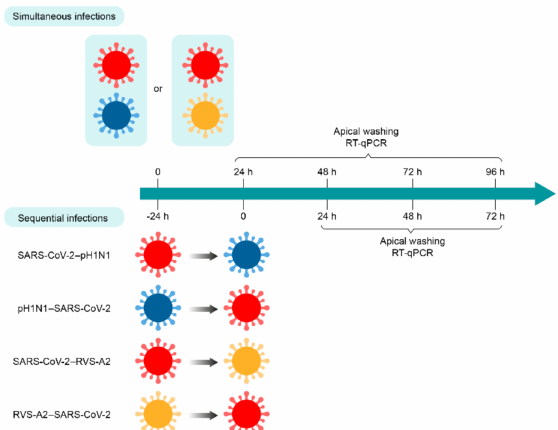
Figure 1. Timelines of simultaneous and sequential infections of nasal human airway epithelium (HAE) with SARS-CoV-2 and A(H1N1)pdm09 or RSV-A2 virus combinations. Nasal HAE was simultaneously or sequentially (24 h apart) infected with SARS-CoV-2/influenza A(H1N1)pdm09 or SARS-CoV-2/RSV-A2 virus combinations at the apical pole. Matched single virus infection conditions were performed in parallel. Viral loads of SARS-CoV-2, A(H1N1)pdm09 and RSV-A2 were determined by RT-qPCR in apical pole washings harvested every 24 h. Key: SARS-CoV-2, influenza A(H1N1)pdm09 virus (pH1N1) and RSV-A2 are represented in red, blue and yellow,